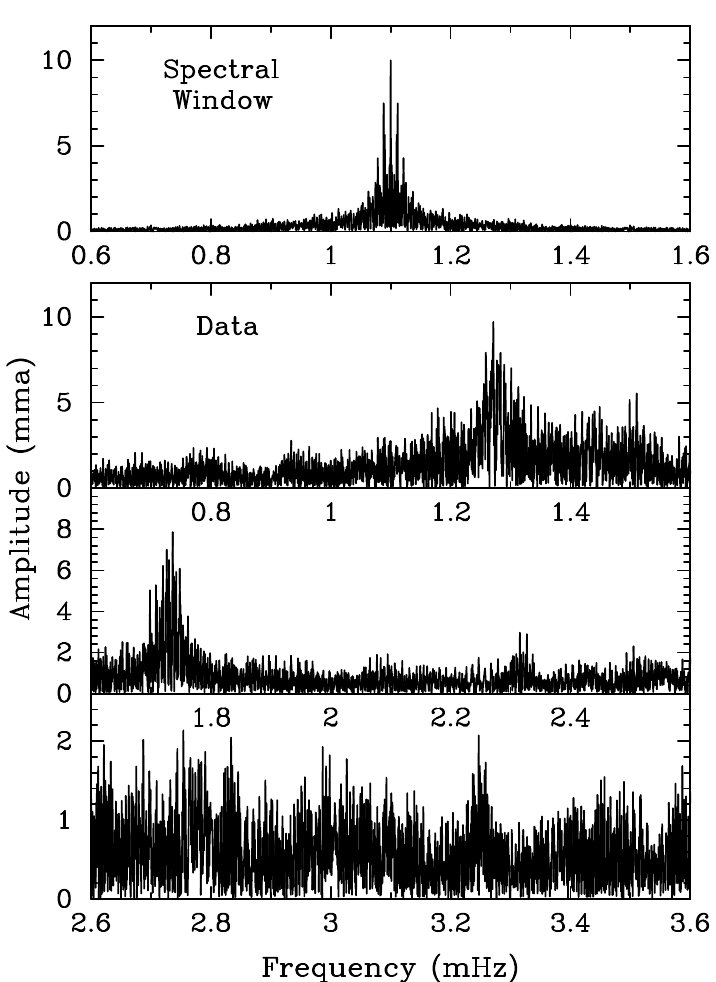
Fig. 5. Fourier spectral window and amplitude spectra of the XCov21 observations of PG 1654+160, adapted from Handler et al.